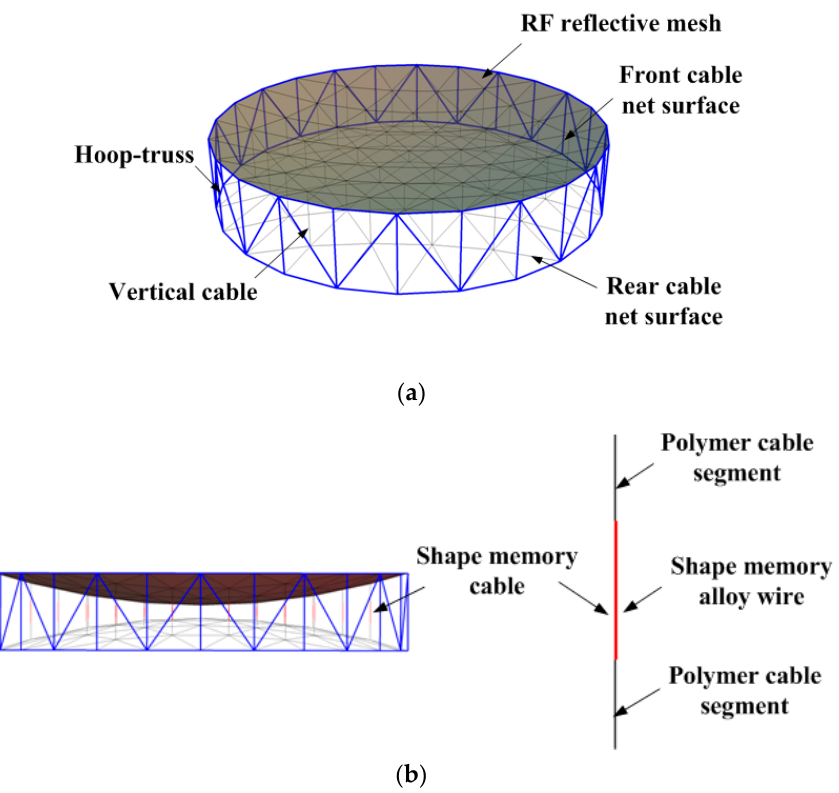
Figure 1. Shape memory cable-net (SMC) structure: ( a ) Composition of AstroMesh-like antenna structure and ( b ) integration mode.